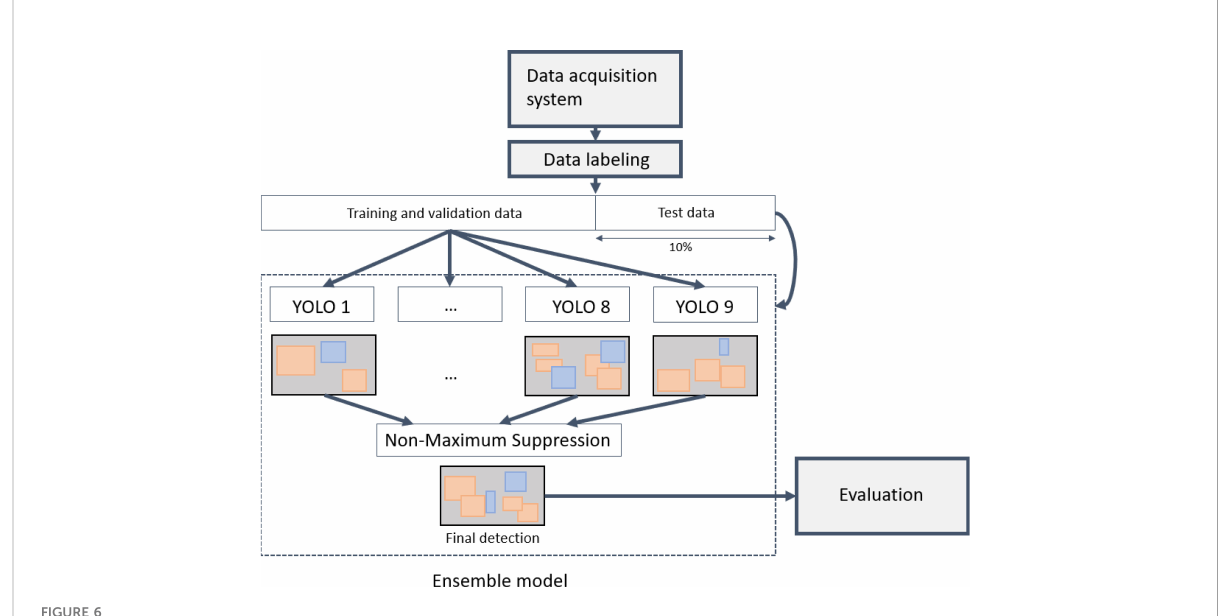
FIGURE 6 Overall process from data acquisition to model training and